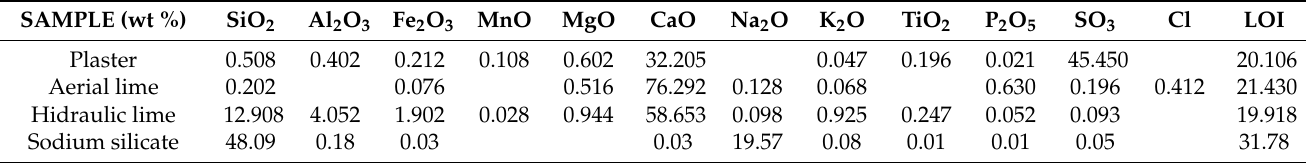
Table 3. Chemical composition by XRF analysis (wt %) of each raw material. Data normalized to 100% (LOI-free), loss on